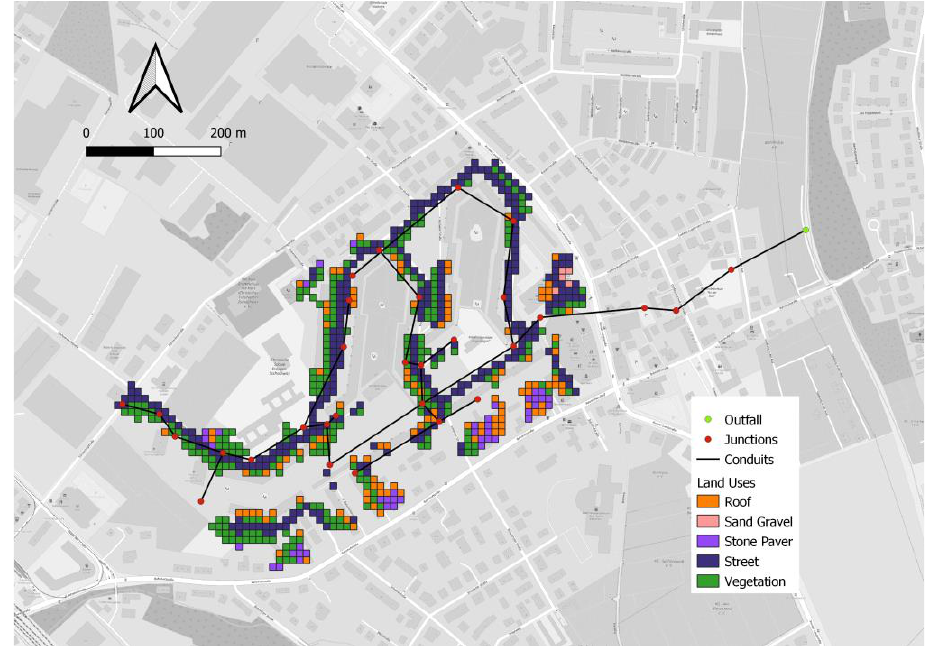
Figure 1. Case Study Area representing land uses and drainage